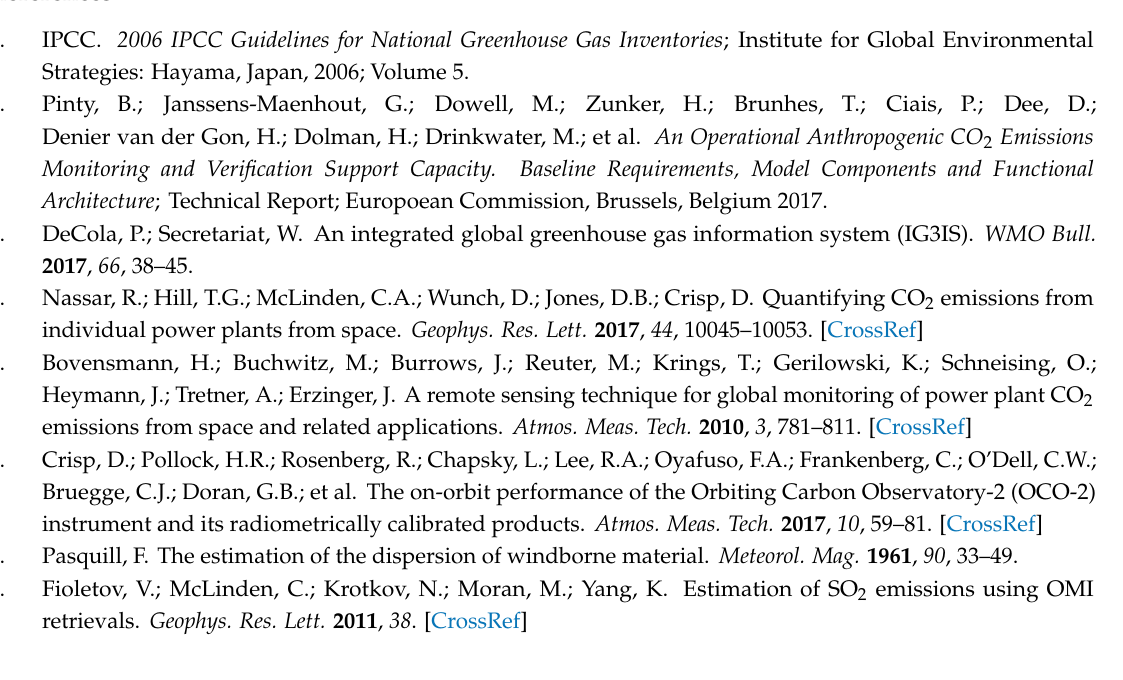
s1. Figure S1: Simulated topography, Figure S2: Simulated topography bias, Figure S3: Footprint bias, Figure S4: Cloud mask bias, Figure S5: Albedo bias, Figure S6: Swath mask biases, Figures S7–S15: Results for individual biases, Figure S16: Daily power plant emissions for 2016–2018. The data files containing derived weekly and hourly scale factors are available online at